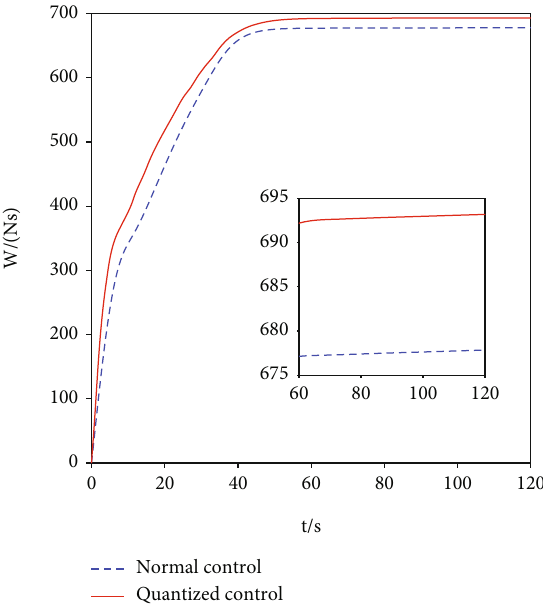
Figure 21: Relative angular velocity error curves.